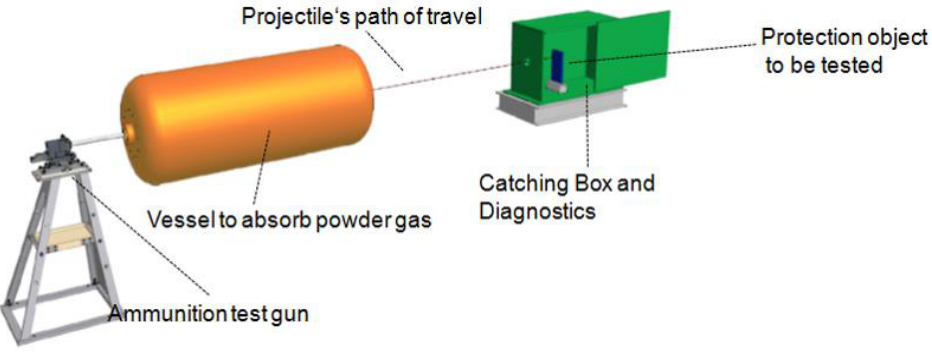
Figure 1. Experimental setup for ballistic experiments [16].